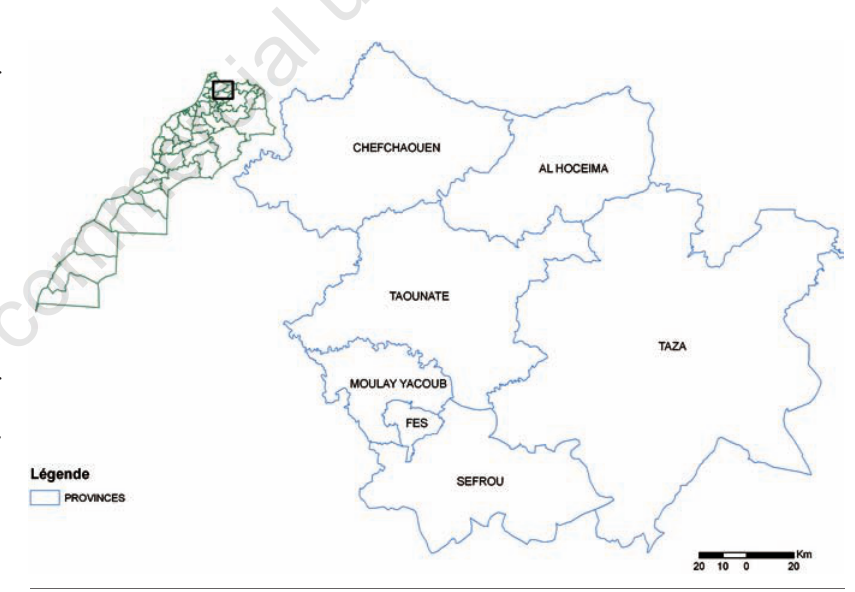
Figure 1. Endemic areas with visceral leishmaniasis in northern Morocco.